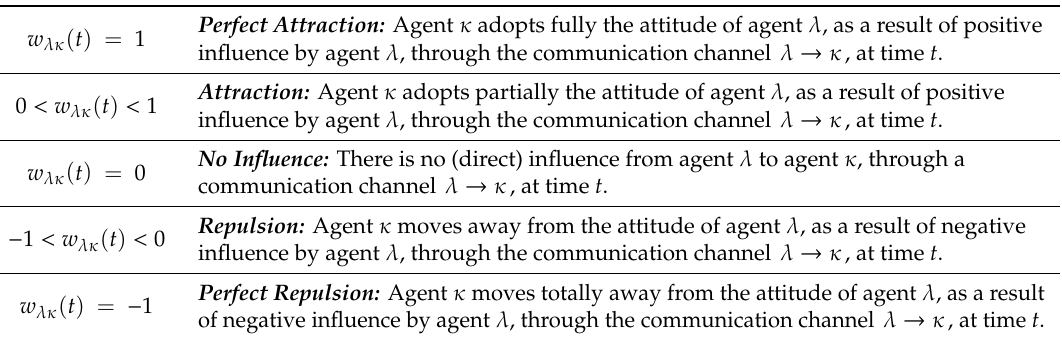
Table 1. Weight values and attitude